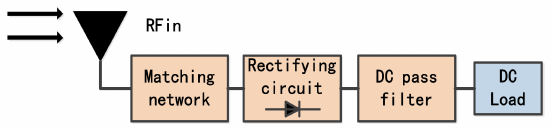
Figure 2. Structure diagram of the single microwave rectifier circuit.